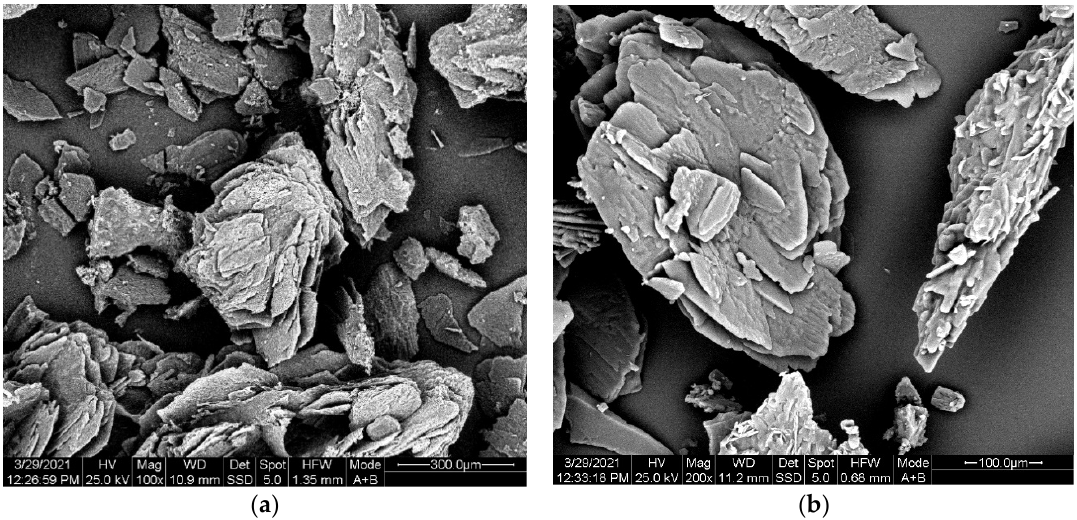
Figure 4. SEM images of PA 612 salt. ( a ) magnification 100× and ( b ) magnification 200×.